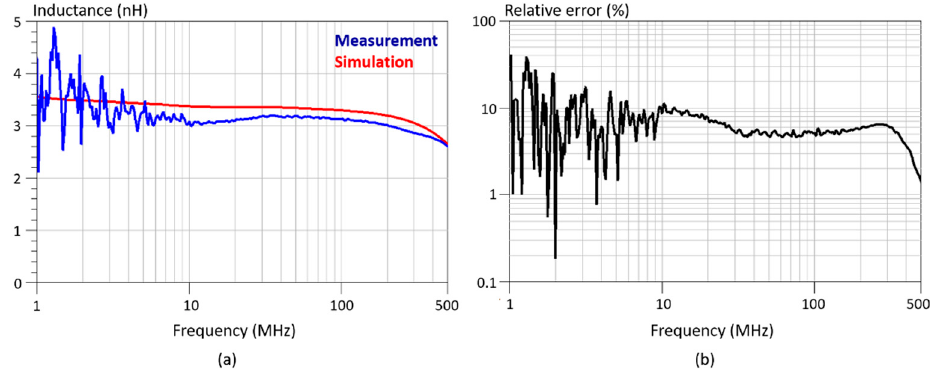
Figure 20. Vertical PCB loop inductance extraction: ( a ) measurement vs. simulation; ( b ) relative error.